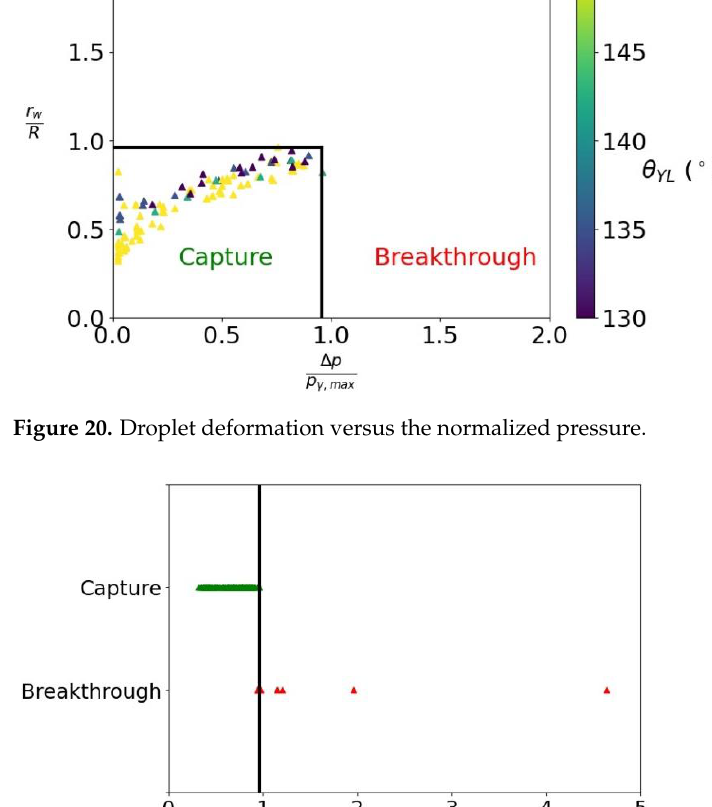
Figure 21. Capture–breakthrough regimes for a large water droplet clogging a wire mesh screen in diesel. Green triangles represent captured droplets by the wire mesh screen and red triangles represent the droplets which are ruptured by the pressure force